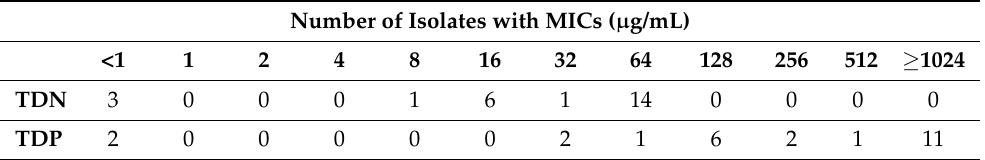
Table 2. Distribution of minimum inhibitory concentrations of TDN, TDP against MDR P. aeruginosa isolates (25 isolates).